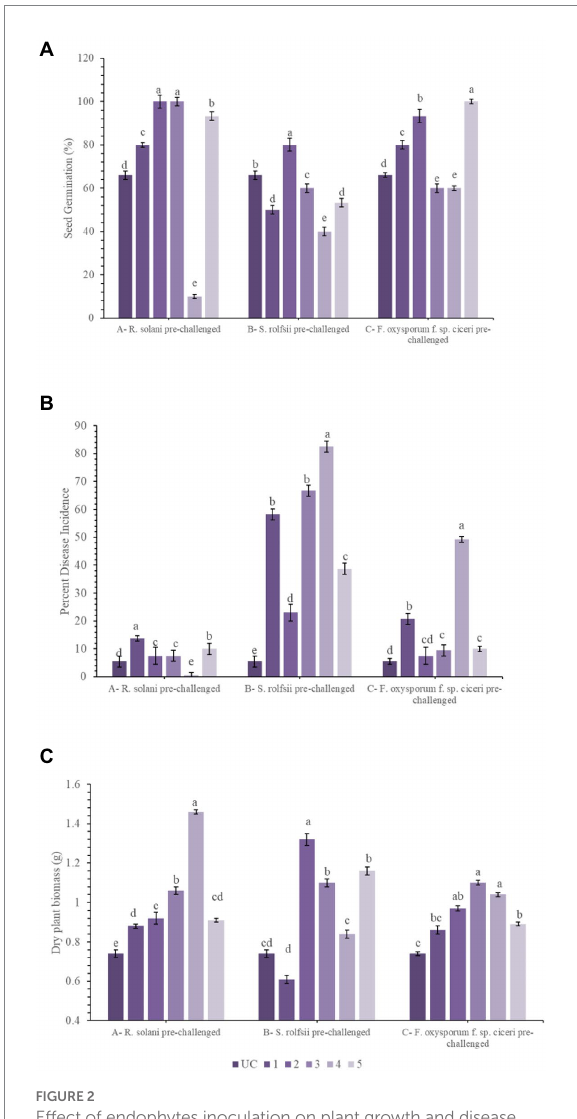
FIGURE 2 Effect of endophytes inoculation on plant growth and disease incidence in chickpea [ A , Seed Germination (%); B , Percent Disease Incidence; C , Dry plant biomass (g)]. Treatment details: UC-Uninoculated (negative control which is not inoculated with a pathogen or bacterial strain). A1, B1, C1 – Positive control of R. solani , S. rolfsii, and F. oxysporum f. sp. ciceri , respectively in which only pathogen inoculated. A2, B2, C2-Respective pathogen + B. subtilis strain TRO4 inoculated. A3, B3, C3- Respective pathogen + B . subtilis strain CLO5 inoculated. A4, B4, C4-Respective pathogen + B. subtilis strain PLO3 inoculated. A5, B5, C5-Chemical control (Respective pathogen + Carbendazim at 2 g per kg of seed). The PDI was calculated based on the number of plants germinated. Data are mean (n = 5) and vertical bars represent standard